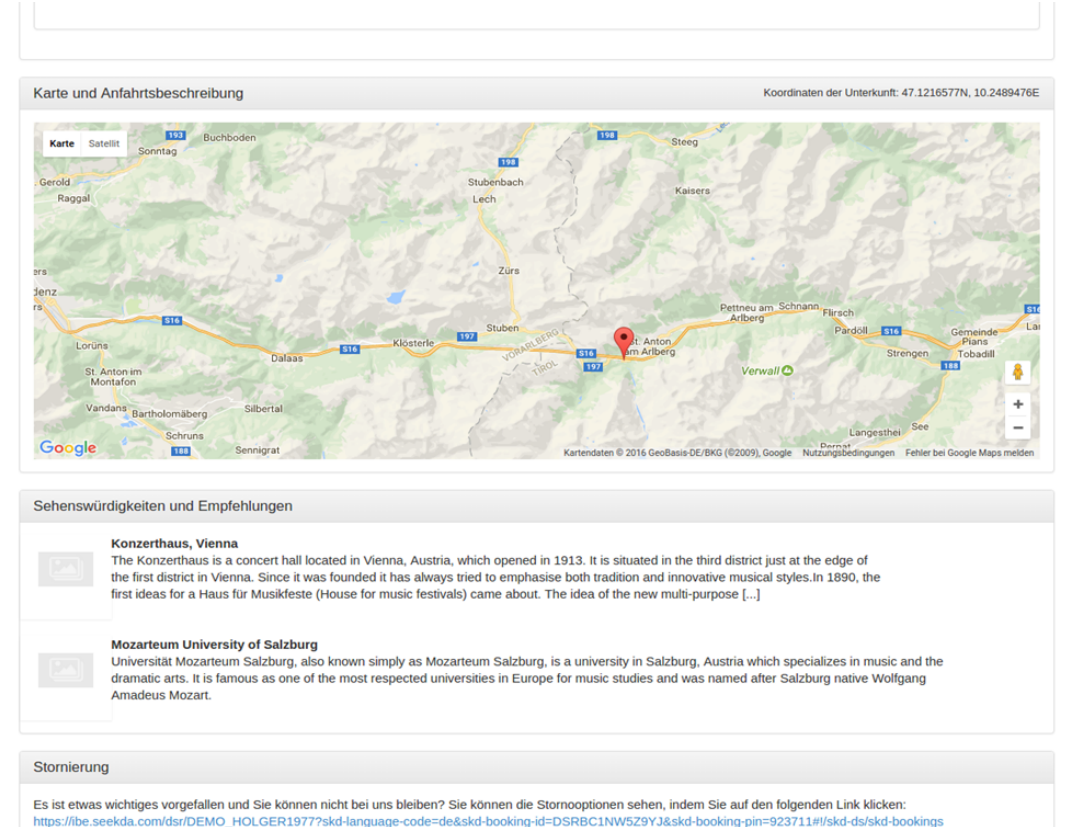
Figure 5. Packages integration within Kognitiv booking engine (guests’